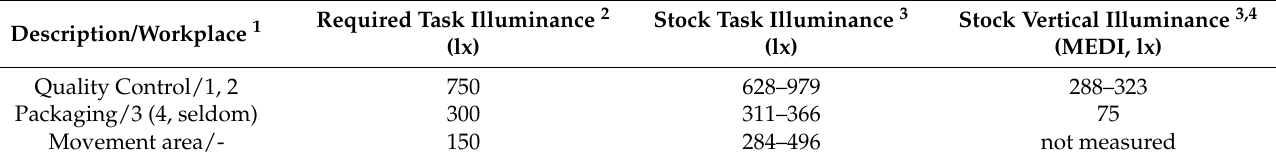
Table 1. Lighting requirements and stock measurements inside the relevant workspace.